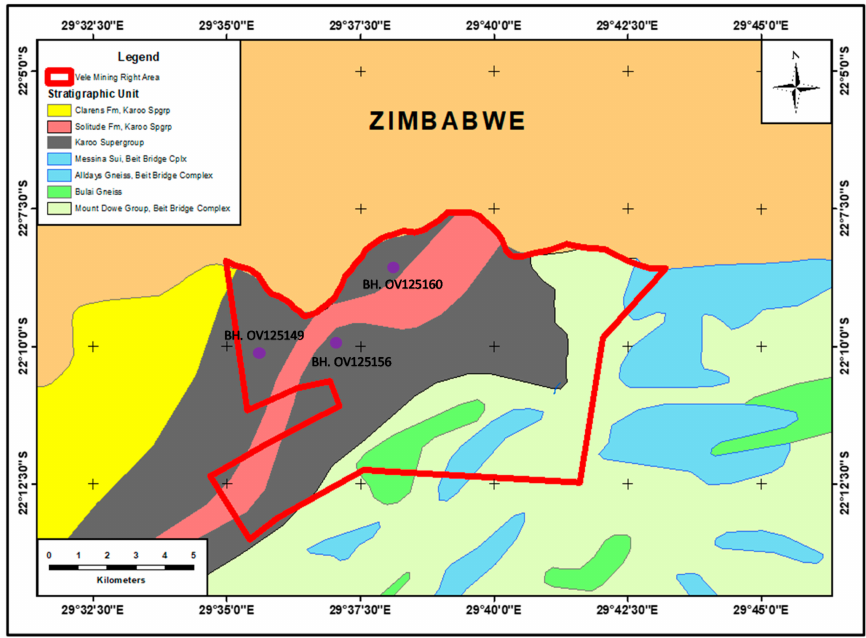
Figure 2. Local geology of Vele Mining Right area (after